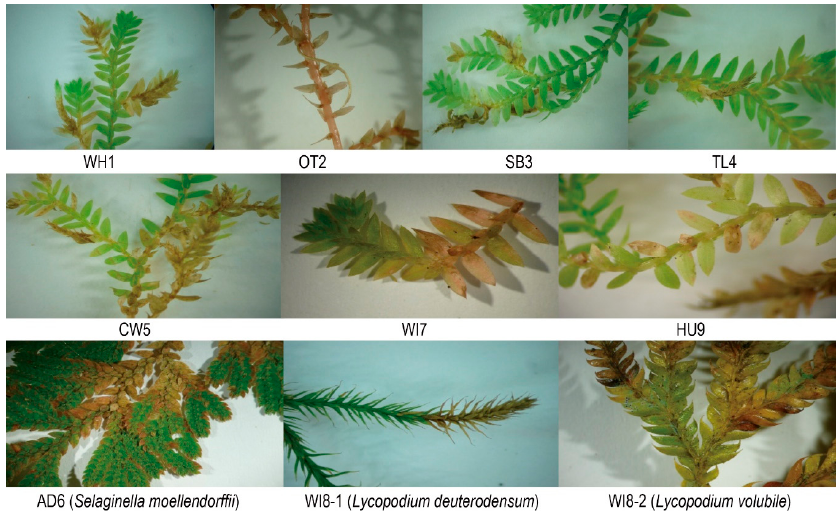
Figure 2. Symptoms suggesting disease on Selaginella and Lycopodium at nine locations. All Selaginella populations exhibited some symptoms of diseased tissue.